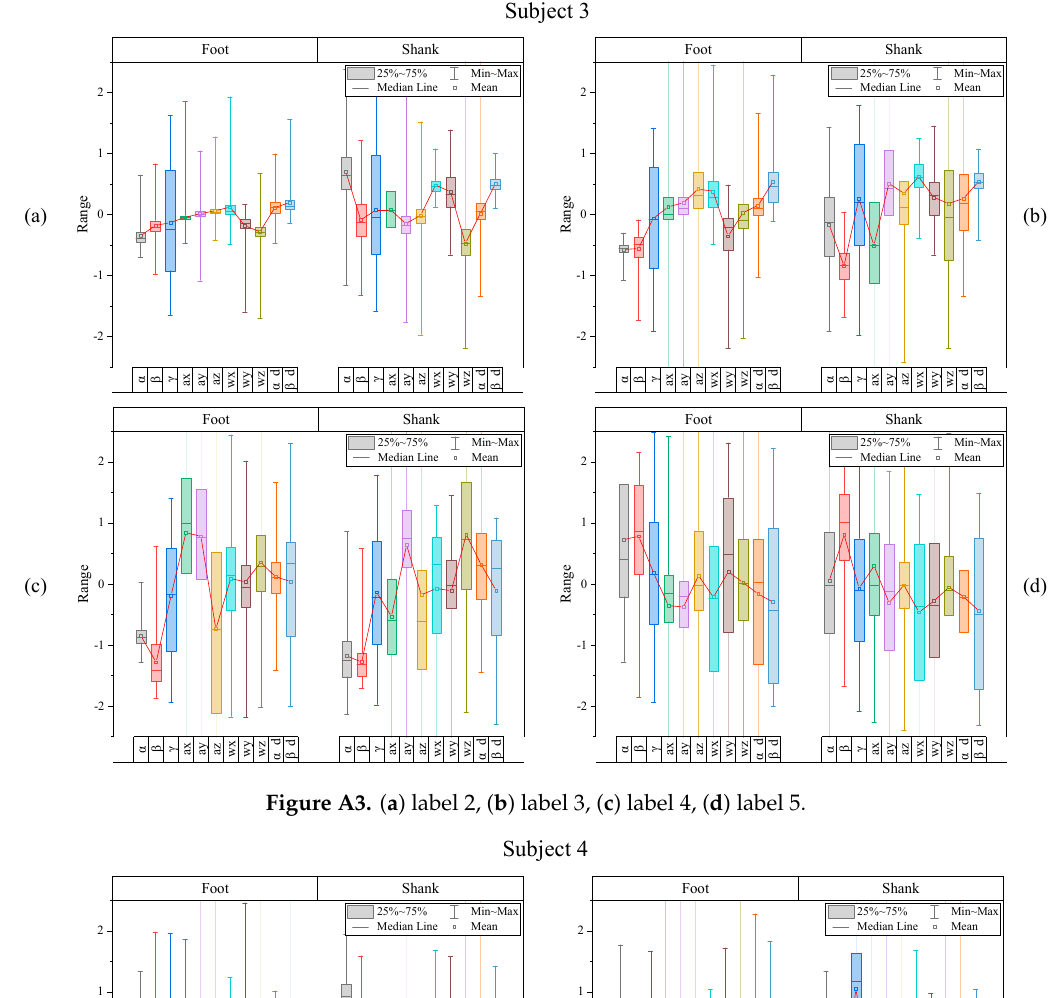
Figure A3. ( a ) label 2, ( b ) label 3, ( c ) label 4, ( d ) label 5.